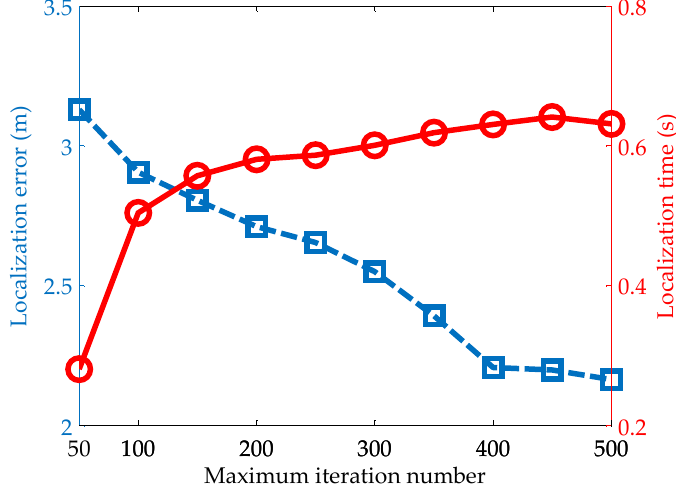
Figure 4. Impacts of the maximum iteration number on localization accuracy and